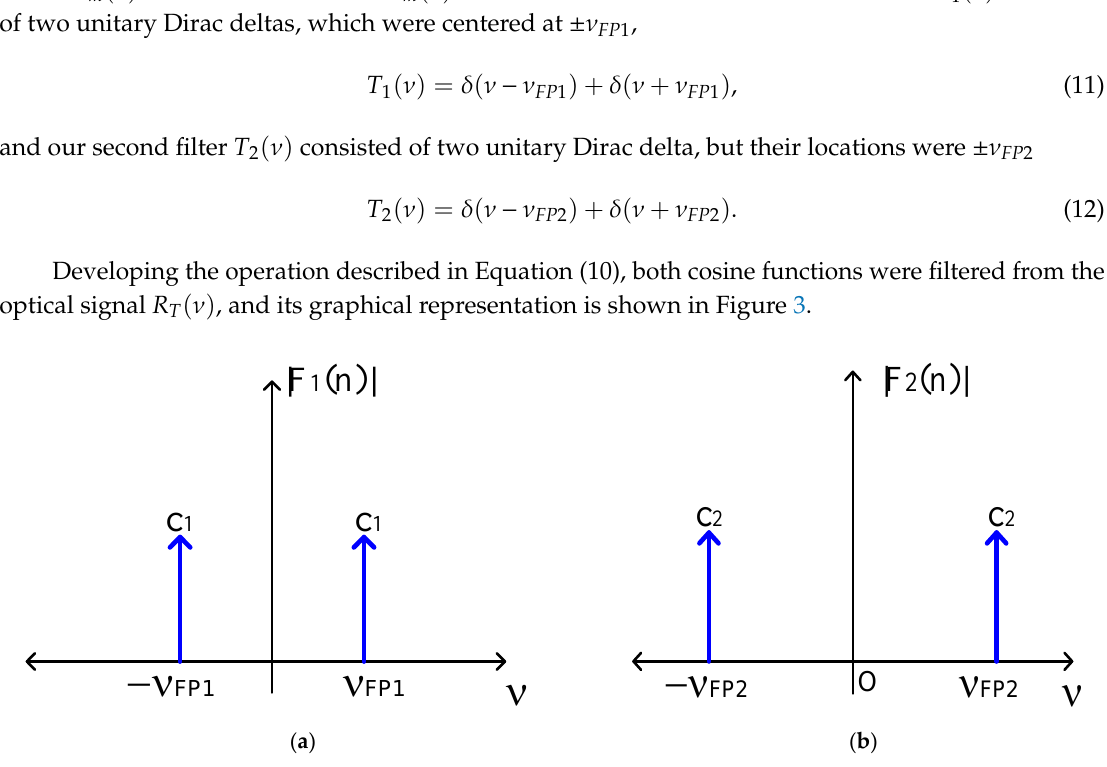
Figure 3. ( a ) cosine function 𝐹 1 (𝜈) filtered from the first interference pattern; ( b ) cosine function 𝐹 2 (𝜈) filtered from the second interference pattern.